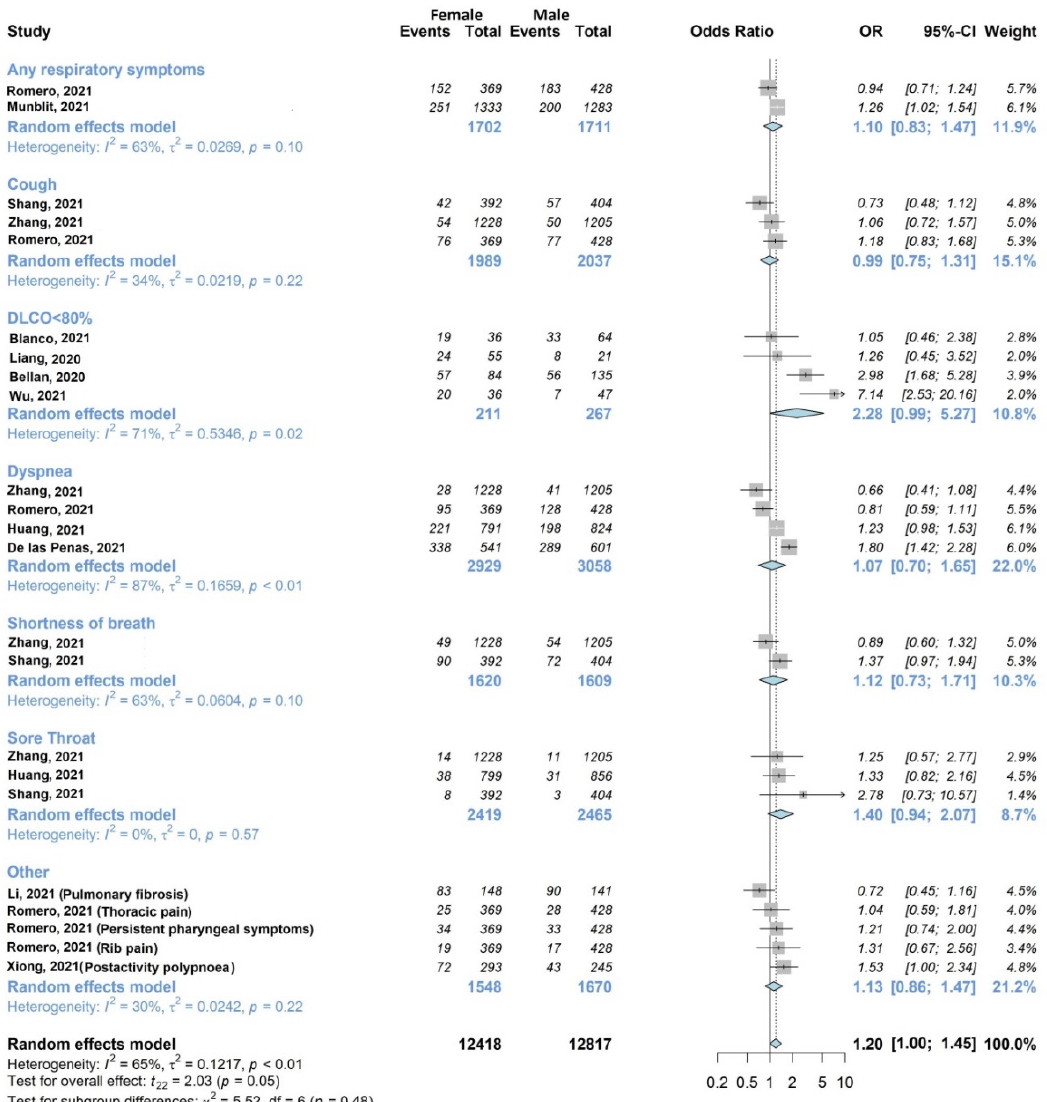
Figure 3. Forest plots of adjusted analyses for association between sex (female) and respiratory symptoms. HKSJ, Hartung-Knapp-Sidik-Jonkman.